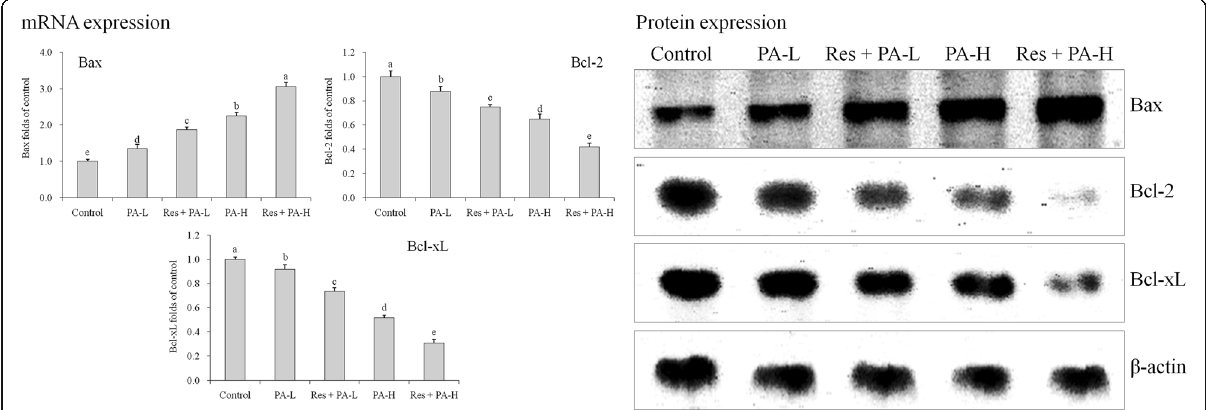
Fig. 5 The mRNA and protein expression of Bax, Bcl-2 and Bcl-xL in HepG2 human liver cancer cells. a-e Mean values with different letters over the bars are significantly different ( P < 0.05) according to Dunnett ’ s post-hoc test. PA-L: 5 μ g/mL of paclitaxel; Res + PA-L: 10 μ g/mL of resveratrol +5 μ g/mL of paclitaxel; PA-H: 10 μ g/mL of paclitaxel; Res + PA-H: 10 μ g/mL of resveratrol +10 μ g/mL of